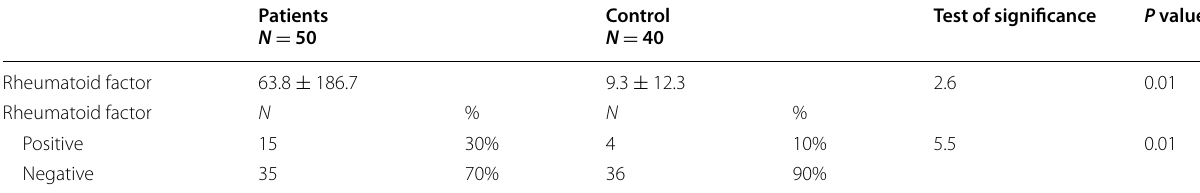
Table 4 Rheumatoid factor in the studied